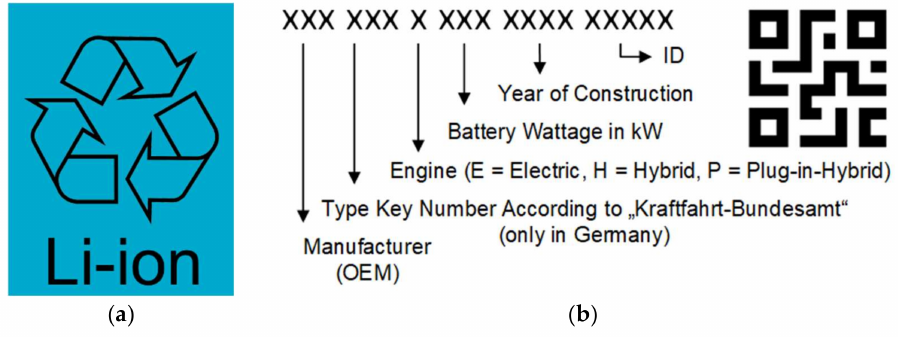
Figure 13. Current label for lithium-ion batteries according to [41] ( a ) and the recommendation for an identity code in combination with a QR code ( b